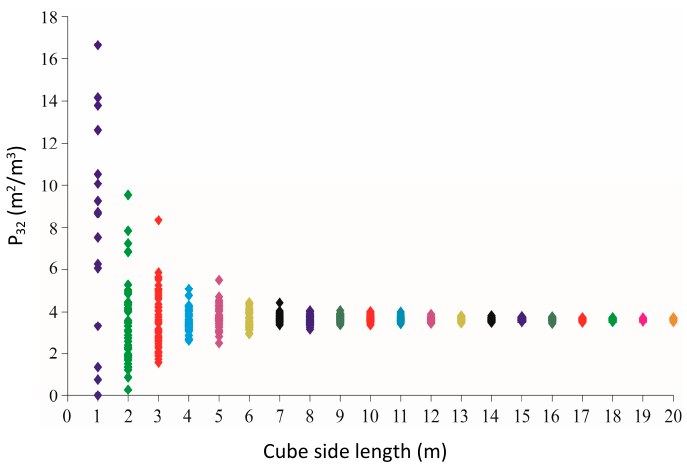
Cube side length (m) Figure 8. The volumetric fracture intensity for different cube sizes. Table 3. The results of the chi-square goodness-of-fit tests for each Figure 8. The volumetric fracture intensity for different cube sizes.